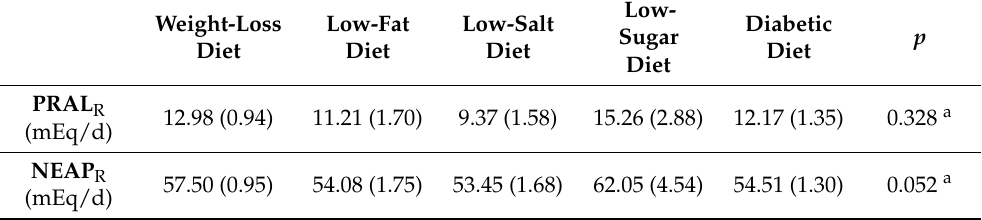
Table 2 legend: a = based on regression analyses followed by adjusted Wald tests. Multivariate linear regression was used to estimate DAL scores of special diets